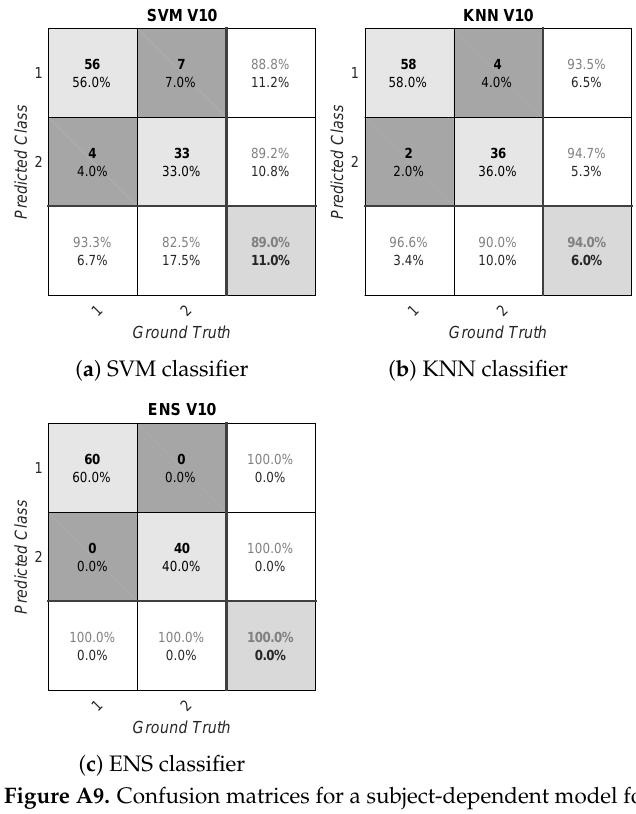
Figure A9. Confusion matrices for a subject-dependent model for V10.